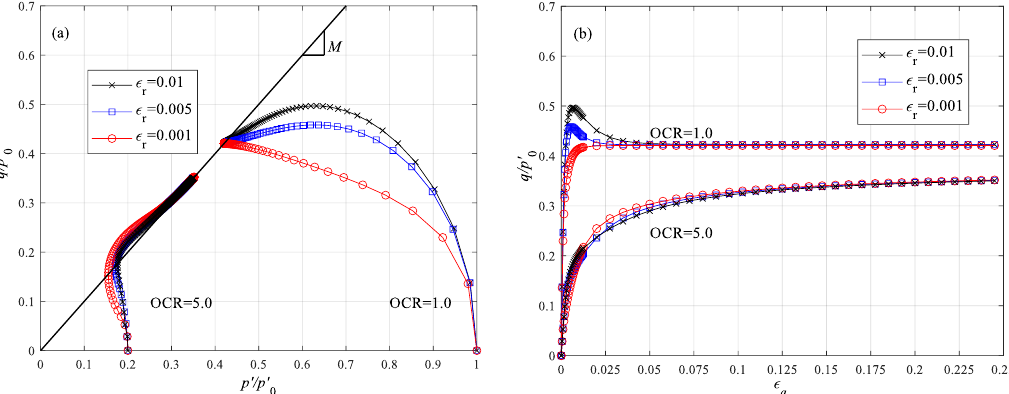
Figure 5. Influence of the reference strain ε r on ( a ) stress paths and ( b ) stress-strain relationships.